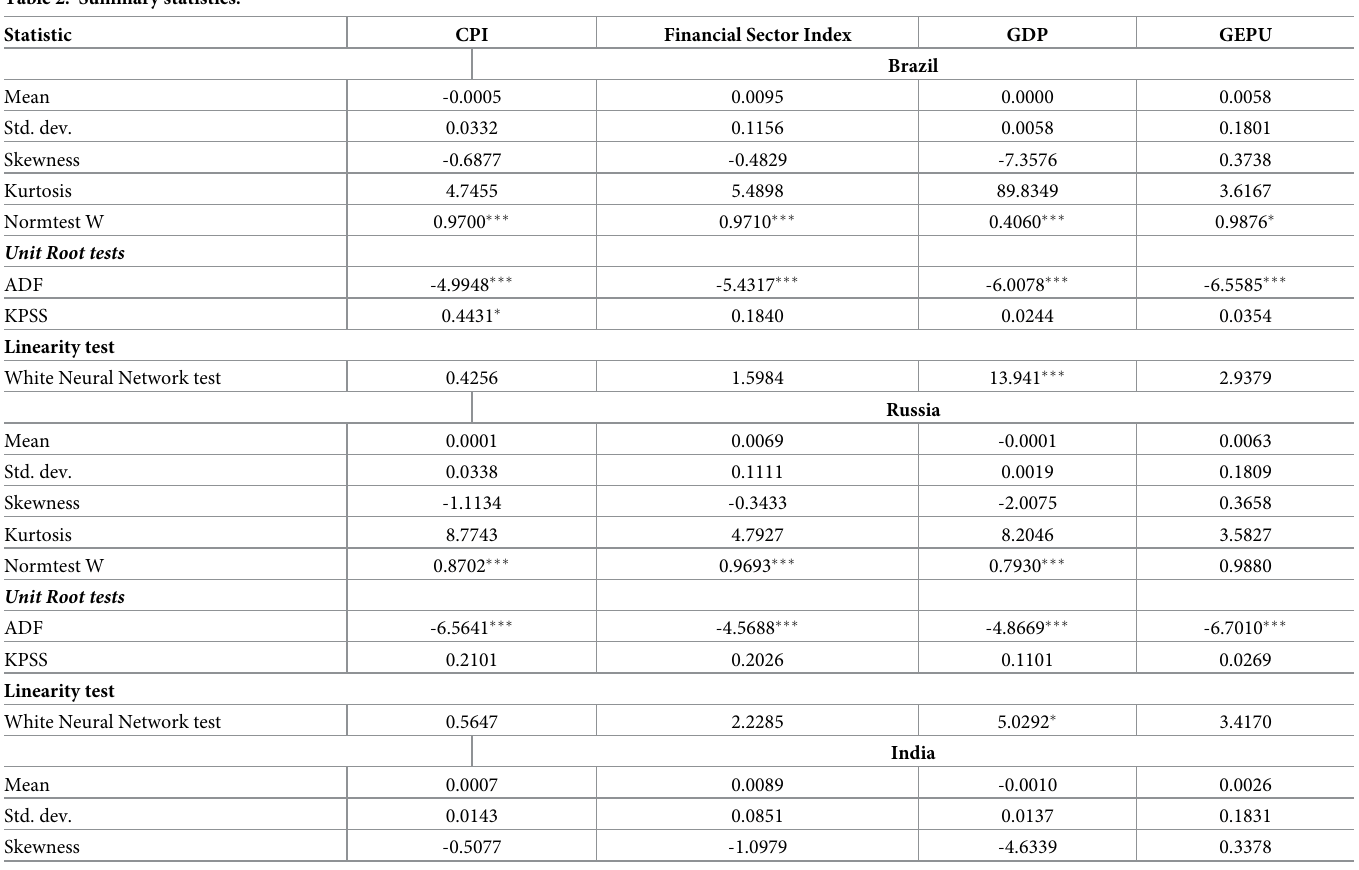
Fig 1. Plots of indices and returns series. https://doi.org/10.1371/journal.pone.0259303.g001 Table 2. Summary